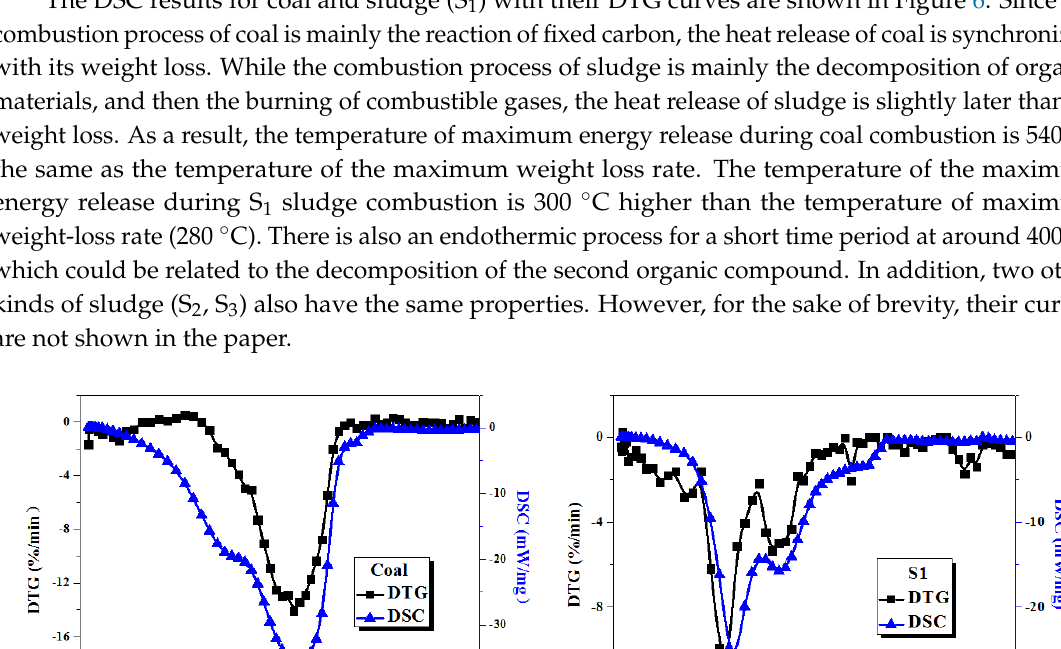
Figure 6. Differential scanning calorimetry (DSC) and DTG curves for coal and S1 sludge sample (heating rate = 30 °C/min) (( a ) coal; ( b ) S 1 ).